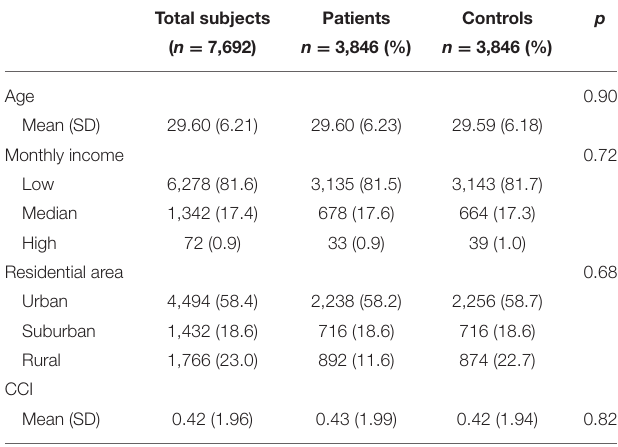
TABLE 1 | Subject demographic data and